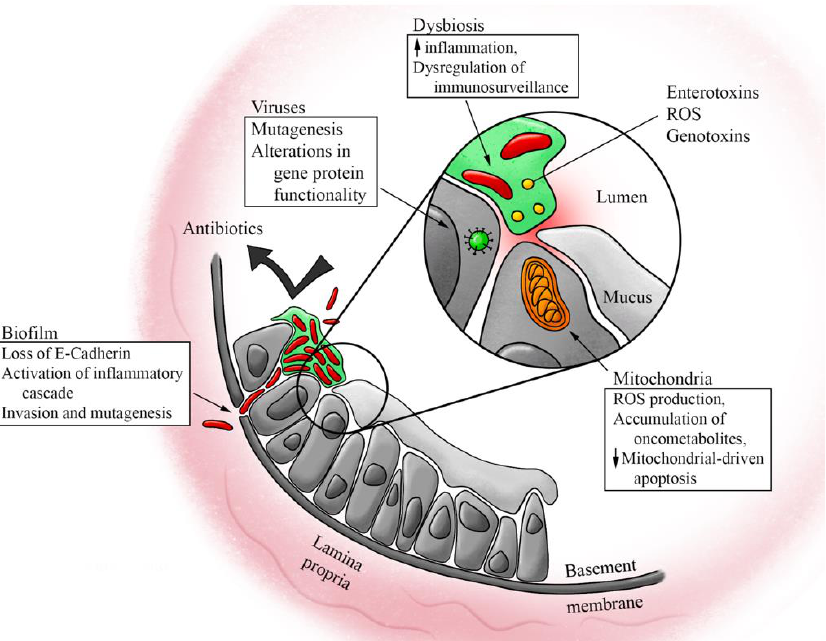
Figure 1. Effects of the microbiome on the pathogenesis and progression of colorectal cancer. Multiple different aspects of the microbiome have been proposed to play a role in the pathogenesis and progression of colorectal cancer, including dysbiosis of the bacterial and viral microbiomes, the biofilms and toxins associated with bacterial dysbiosis, and microbe-mitochondrial crosstalk altering mitochondrial function.